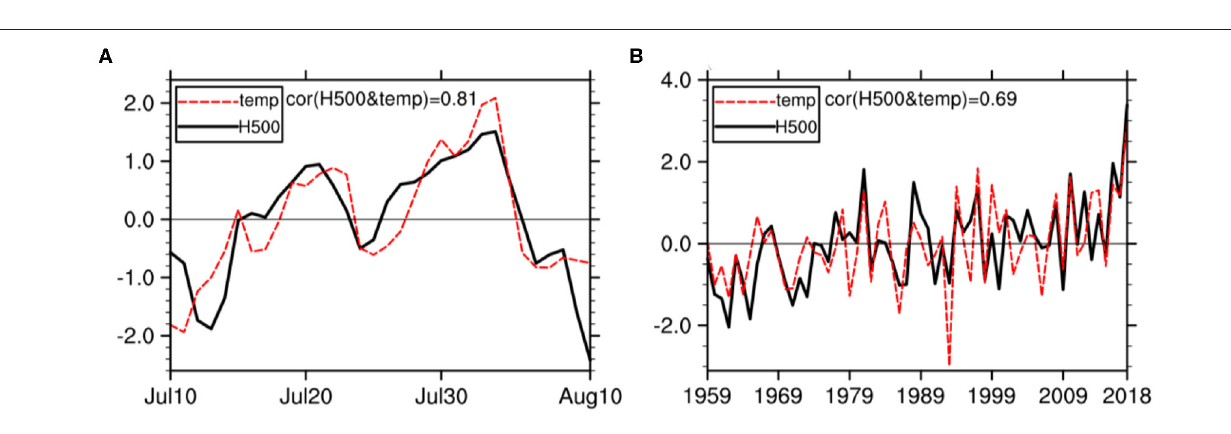
FIGURE 3 | High-temperature regional means (110–130 ◦ E, 35–47.5 ◦ N) of (A) daily normalized 2m temperatures and 500 hPa geopotential heights from July 10th to August 10th, 2018; (B) normalized 2m temperatures and 500 hPa geopotential heights in the multiyear mean daily data from July 18th to August 5th from 1959 to